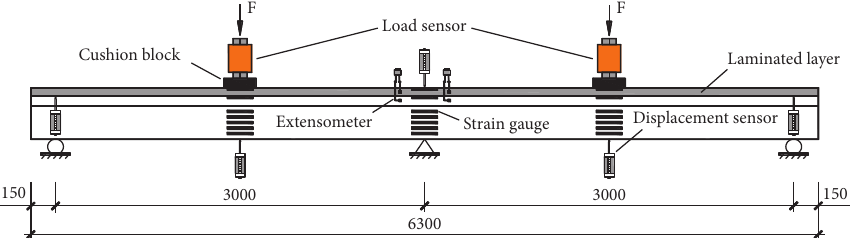
Figure 7: Details of the two-span continuous composite T-shaped beam test setup.